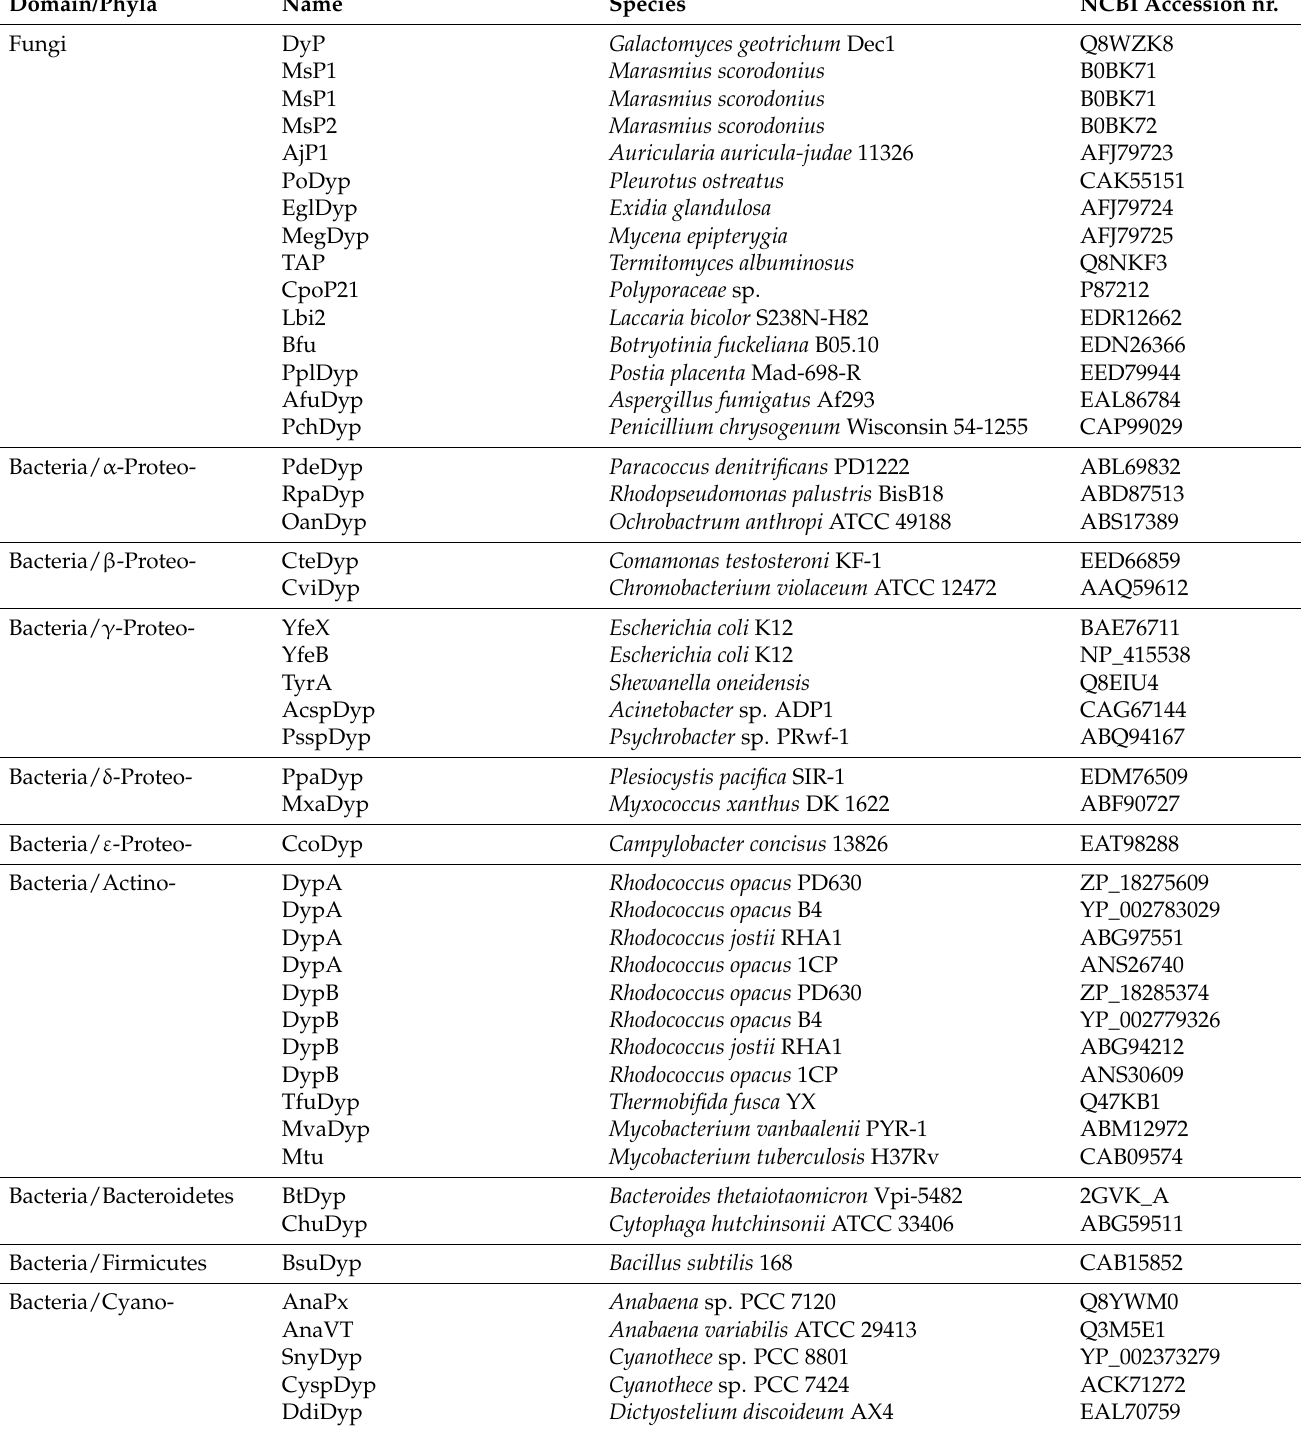
Table A4. Selection of described Dyps and affiliation to domain and